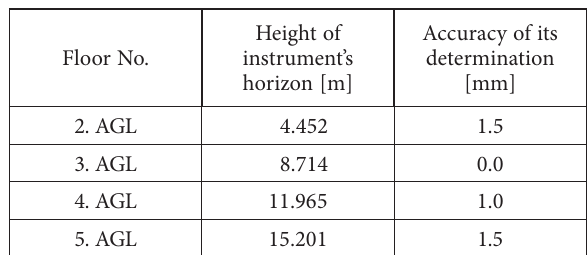
Table 3. Accuracy of relative height determination